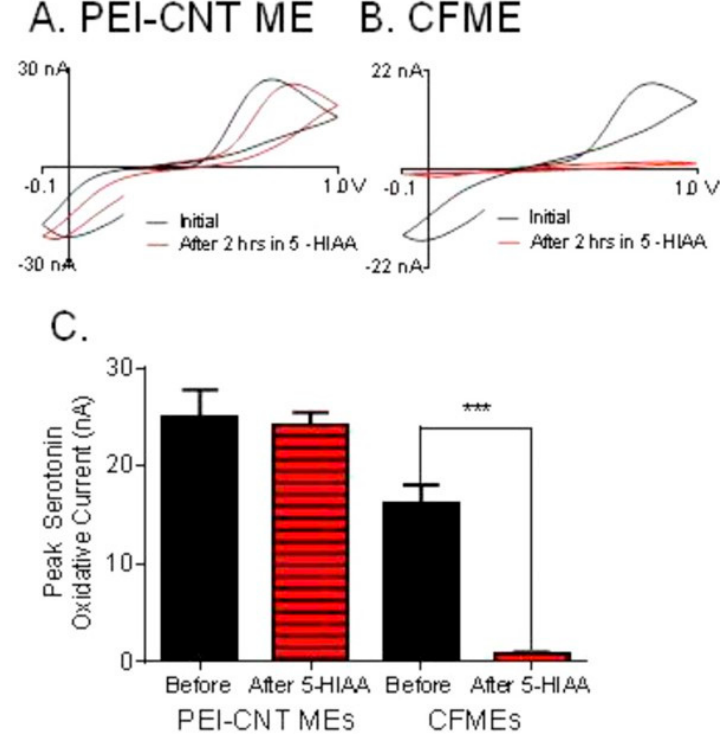
Figure 6. 5-hydroxyindoleacetic acid (5-HIAA) fouling in vitro. One micromolar serotonin was detected at a polyethylenimine CNT (PEI-CNT) fiber electrode before and 2 h after it was bathed in 10 µM 5-HIAA, while the waveform was applied. The applied waveform was the serotonin waveform (0.2 – 1.0 to − 0.1 to 0.2 at 1000 V·s − 1 ). ( A ) The cyclic voltammograms (CVs) are similar before and after 5-HIAA at the PEICNT microelectrodes; ( B ) For carbon-fiber microelectrodes (CFMEs) after 2 h in 10 µM 5-HIAA, the oxidation peak of serotonin was no longer visible; ( C ) Bar graphs depicting the change in peak oxidative current for serotonin prior to and following exposure to 10 µM 5-HIAA for 2 h [64]. Copyright 2014, American Chemical Society.